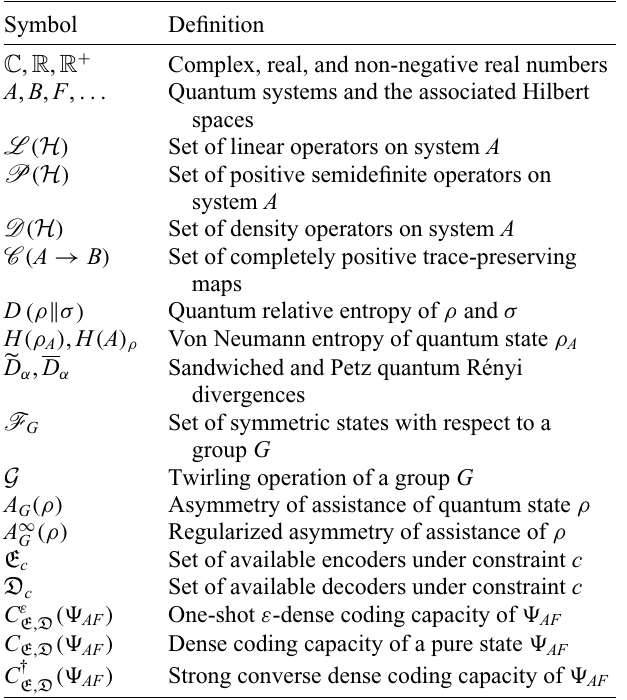
TABLE I. Overview of the notation used throughout this paper.